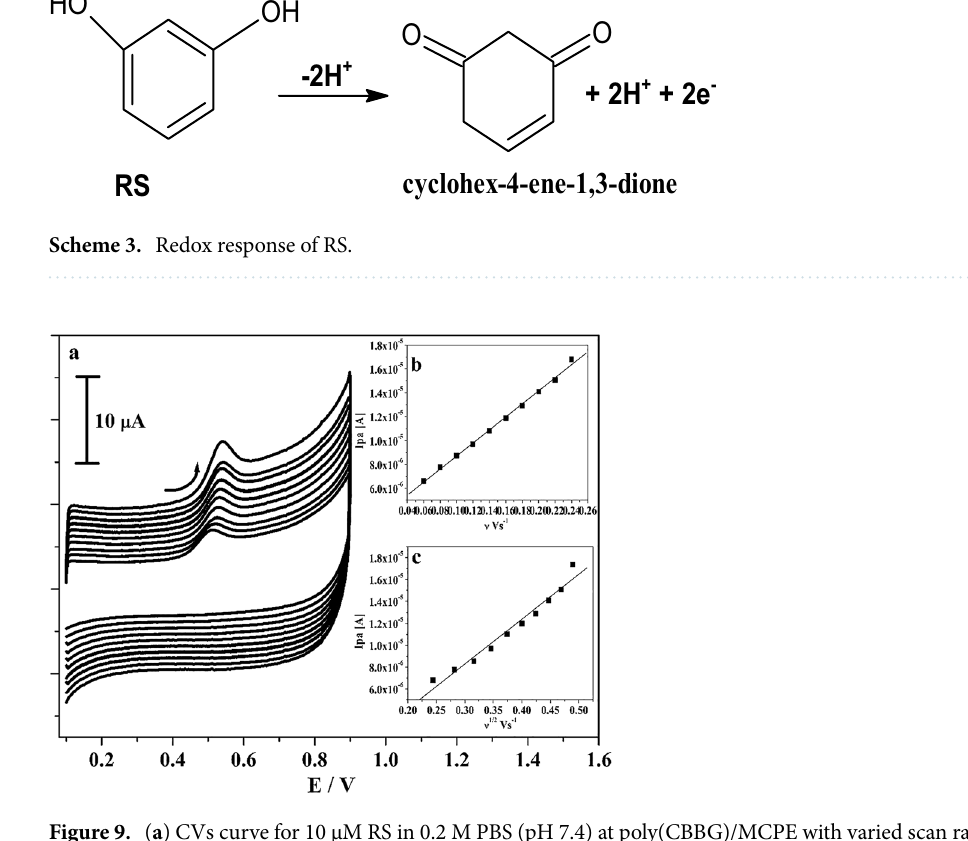
Figure 9. ( a ) CVs curve for 10 µM RS in 0.2 M PBS (pH 7.4) at poly(CBBG)/MCPE with varied scan rates (0.06–0.24 Vs −1 ). ( b ) Graph of Ipa against scan rate. ( c ) Graph of Ipa against square root of scan